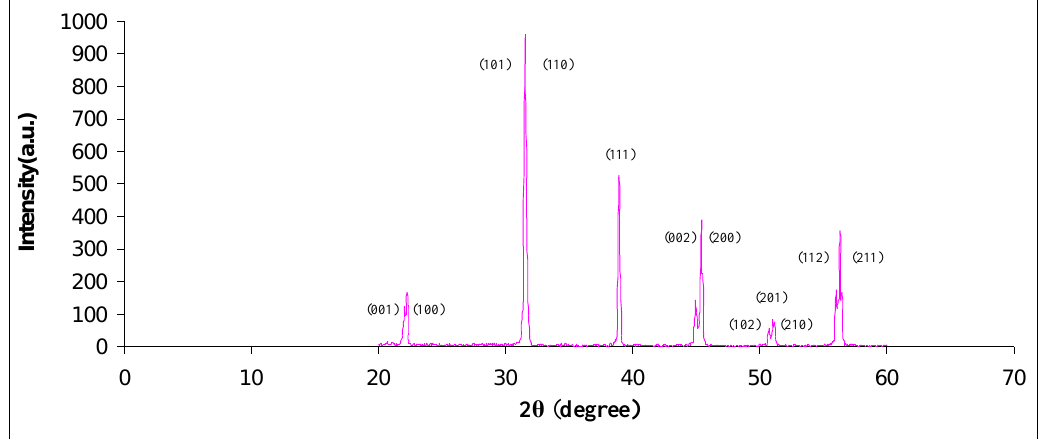
Fig. 6: XRD patterns for barium titanate at 1400 °